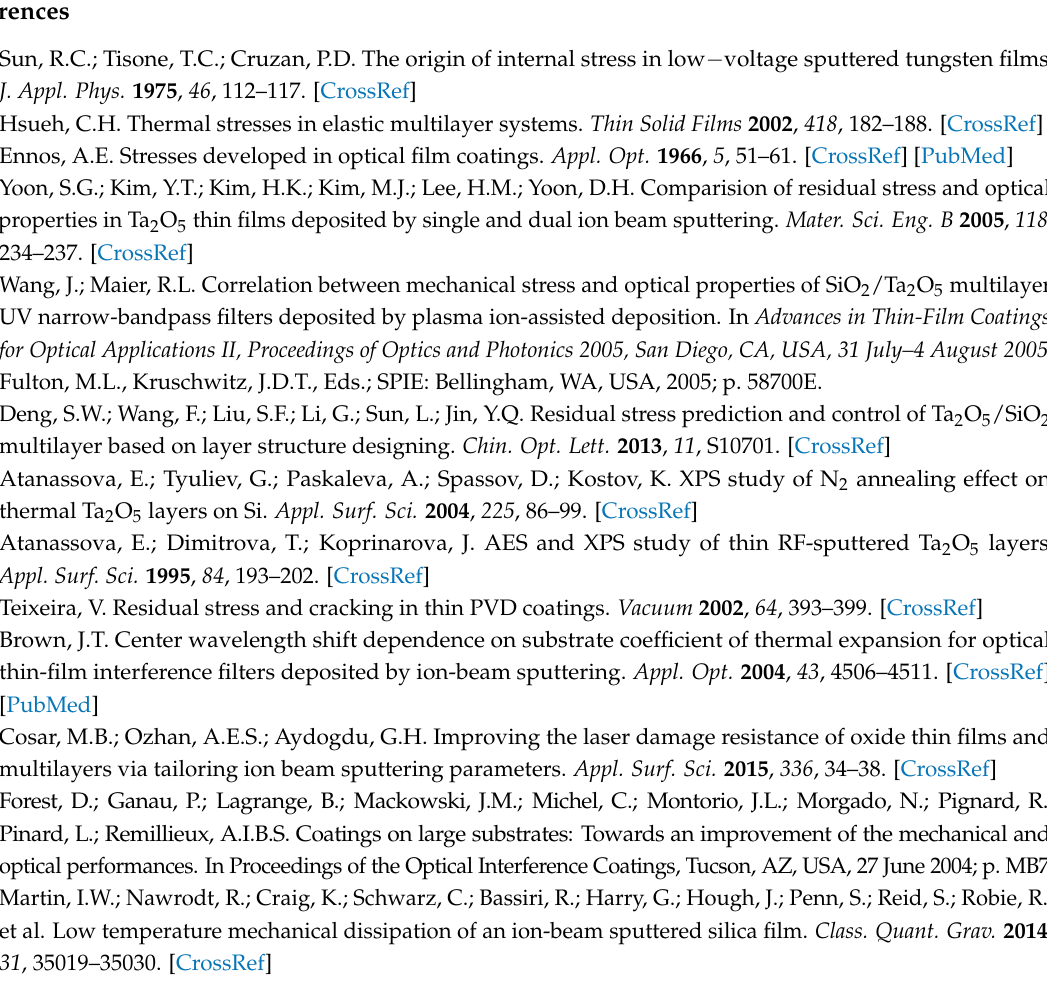
Figure S1: The surface figure of Ta 2 O 5 films on fused silica before deposition, after deposition, and after annealing treatments at various temperatures, Figure S2: XPS survey spectra of Ta 2 O 5 films under various annealing temperature, Figure S3: XPS spectra of oxygen (O 1 s ) with satellite peaks under various annealing temperature, Figure S4: The surface figure of Ta 2 O 5 films on fused silica before deposition, after deposition, and after annealing treatments at various temperatures, Table S1: O/Ta ratio of Ta 2 O 5 films based on XPS survey